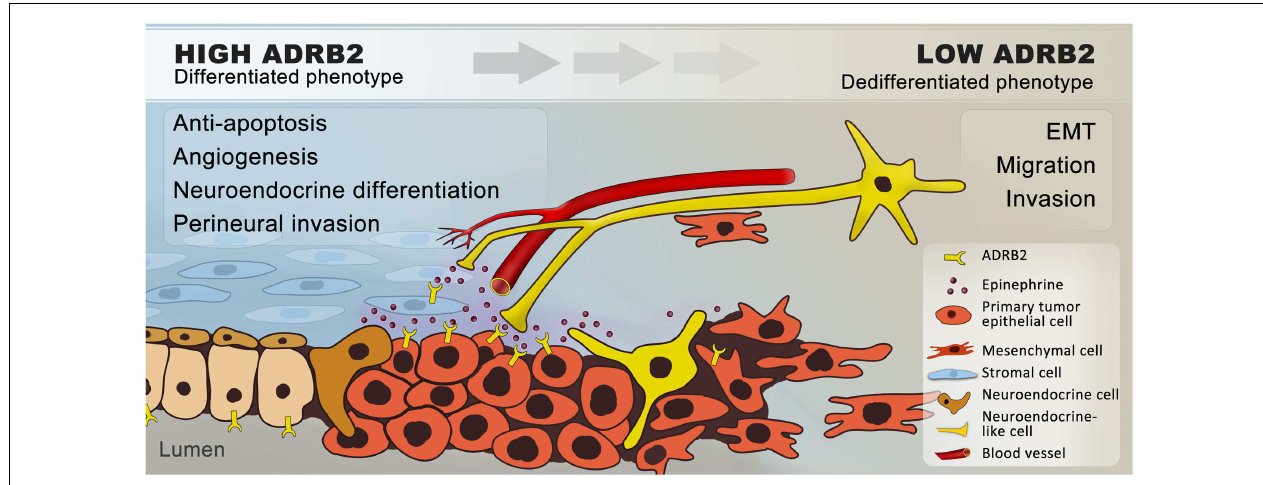
increased and a number of cancer cells undergo trans-differentiation to neuroendocrine-like cells.Together this will favor tumor growth. Angiogenesis and neurogenesis are closely linked (132) and sympathetic activation may stimulate perineural invasion through chemotaxis. In general, chronic ADRB2 activation down-regulates the ADRB2-level, leading to de-differentiation and epithelial–mesenchymal transition, with a subsequent increase in the migratory and invasive potential of the cells. Cancer cells expressing low levels of ADRB2 will thereby follow the nerves and blood vessels to metastatic sites.